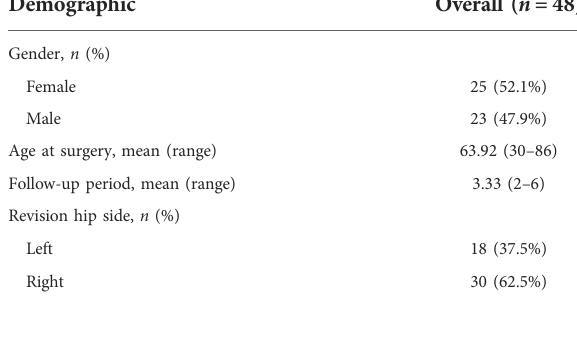
TABLE 1 Patient demographic background